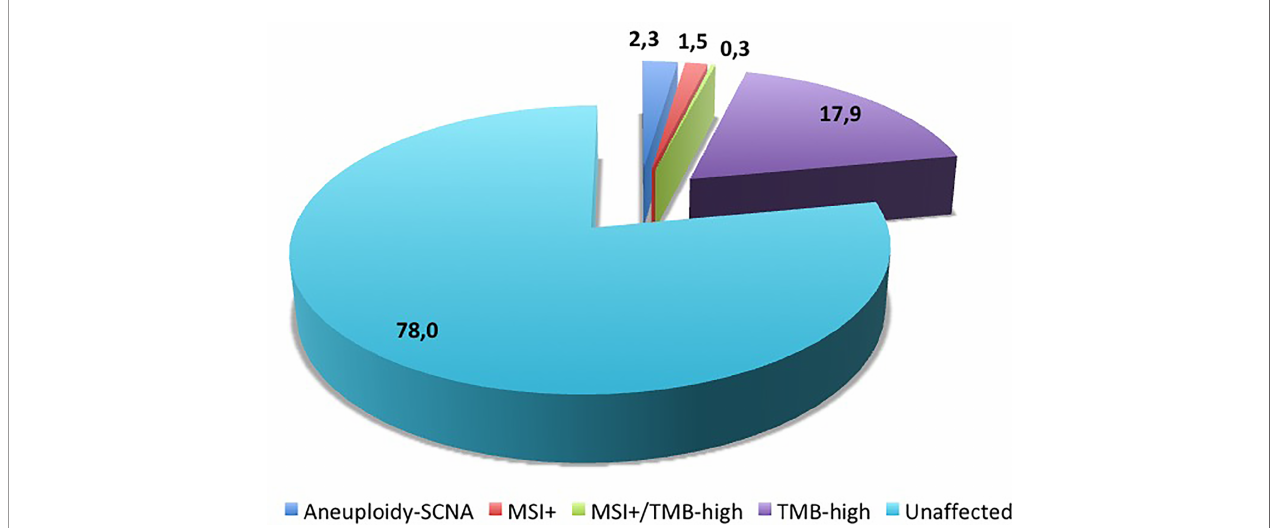
FIGURE 3 | Distribution of molecular alterations linked to genetic instability in melanoma samples. Numbers indicate the percentages of cases reported in literature (see text for references).